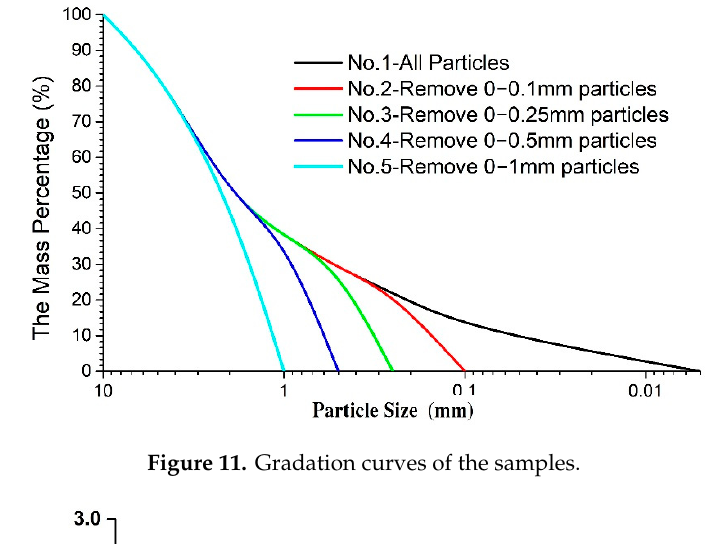
Figure 11. Gradation curves of the samples.